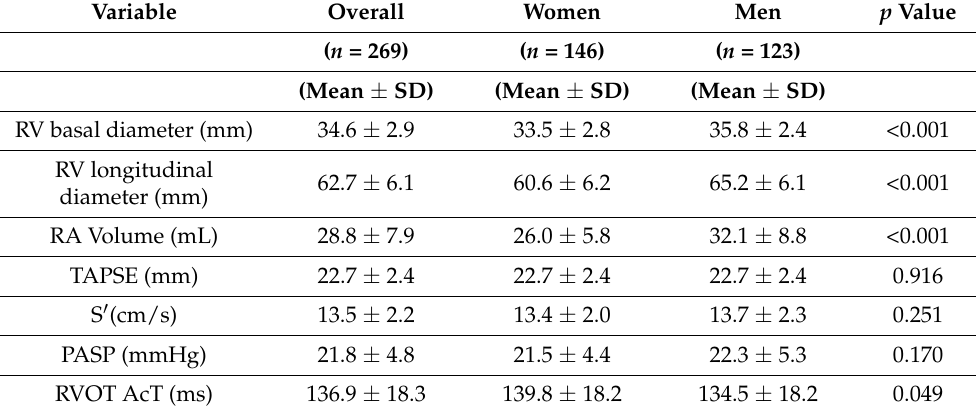
Table 3. Structural and functional variables of the right heart and pulmonary circulation in the study